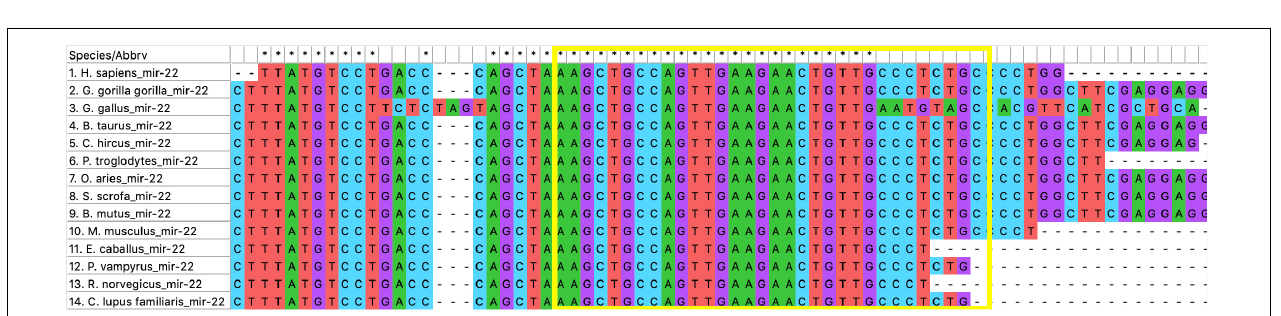
FIGURE 5 | The alignment of miR-22. The yellow box encompasses the sequence of miR-22 for Bos taurus .